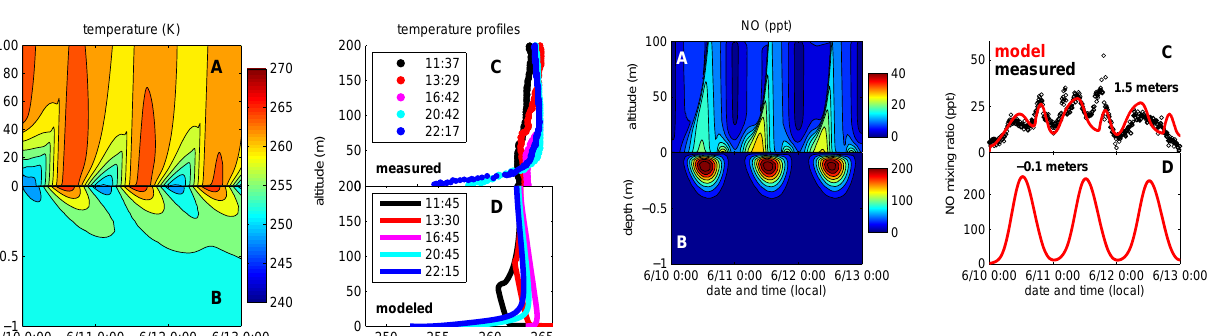
Fig. 5. Modeled NO mixing ratios in the atmosphere (A) and in- terstitial (B) air. Modeled mixing ratios in the atmosphere at an altitude of 1.5m above the snowpack are compared with measure- ments in (C) . Predicted interstitial air mixing ratios 10cm below the snow surface are shown in (D)